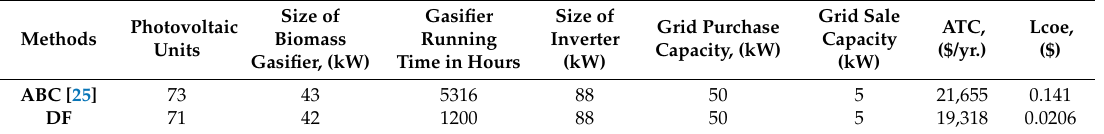
Table 4. Comparison of DF [proposed method] with ABC [25].